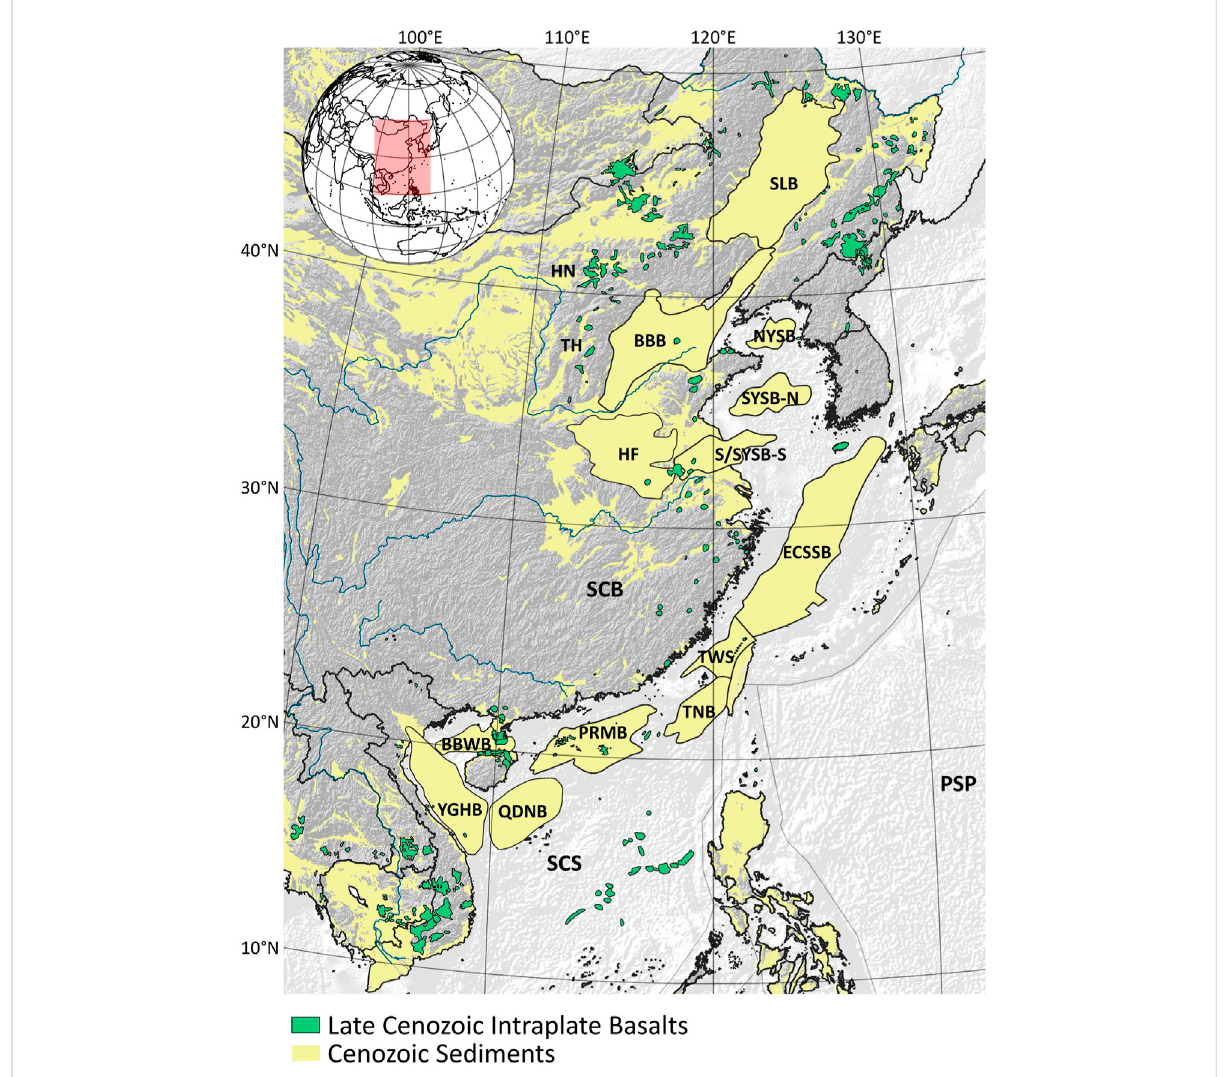
FIGURE 1 MapofthestudyareashowingthedistributionoflateCenozoicintraplatebasaltsconsideredinthisstudy(ingreen)andCenozoicsediments(in yellow), together with the outline of the main sedimentary basins mentioned in the text. Notice the scarcity of Cenozoic sediments in the South China Block. SLB, Songliao Basin; BBB, Bohai Bay Basin; NYSB, North Yellow Sea Basin; SYSB-N, South Yellow Sea Basin Northern Depression; S/ SYSB-S,Subei/SouthYellowSeaBasinSouthernDepression;HF,HefeiBasin;ECSSB,EastChinaSeaShelfBasin;TWS,TaiwanStrait;TNB,Tainan Basin; PRMB, Pearl River Mouth Basin; BBWB, Beibuwan Basin; QDNB, Qiongdongnan Basin; YGHB, Yinggehai Basin; HN, Hannuoba Basalts; TH, Taihang Basalts. SCB, South China Block; SCS, South China Sea; PSP, Philippine Sea